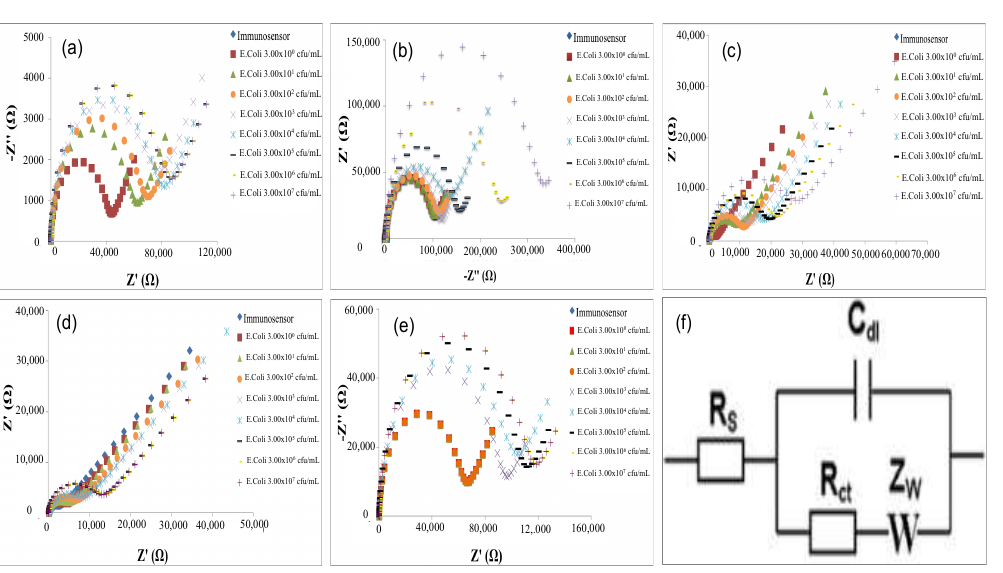
Figure 4. Nyquist plots in impedance measurements before and after the interaction of the immunosensors with different E. coli concentrations, for all immobilization procedures tested in this work: ( a ) Au-MBA-Ab; ( b ) Au-MBA-Protein A/G-Ab; ( c ) Au-Cys-Ab; ( d ) Au-Cys-Ferrocene-Ab; ( e ) Cys-PAMAM-Ferrocene-Ab; ( f ) Randle’s